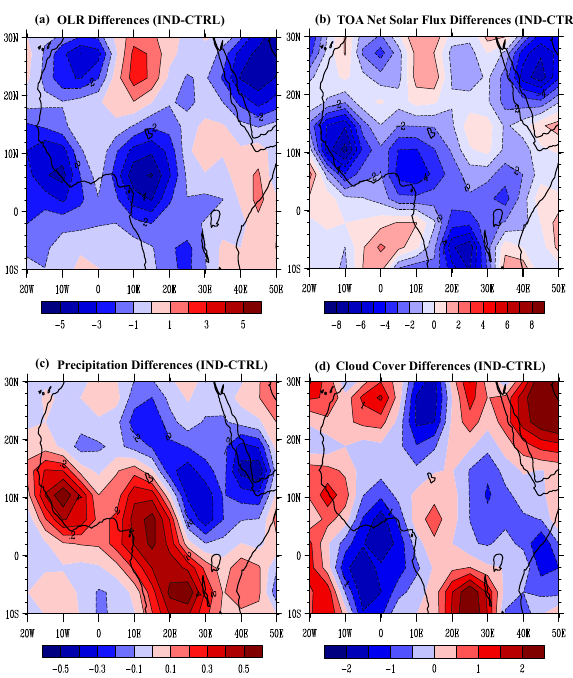
Fig. 5. JJA differences in (a) OLR (Wm − 2 ) , (b) TOA net solar flux (Wm − 2 ) , (c) precipitation (mm day − 1 ) , and (d) cloud cover (%) between experiments IND and